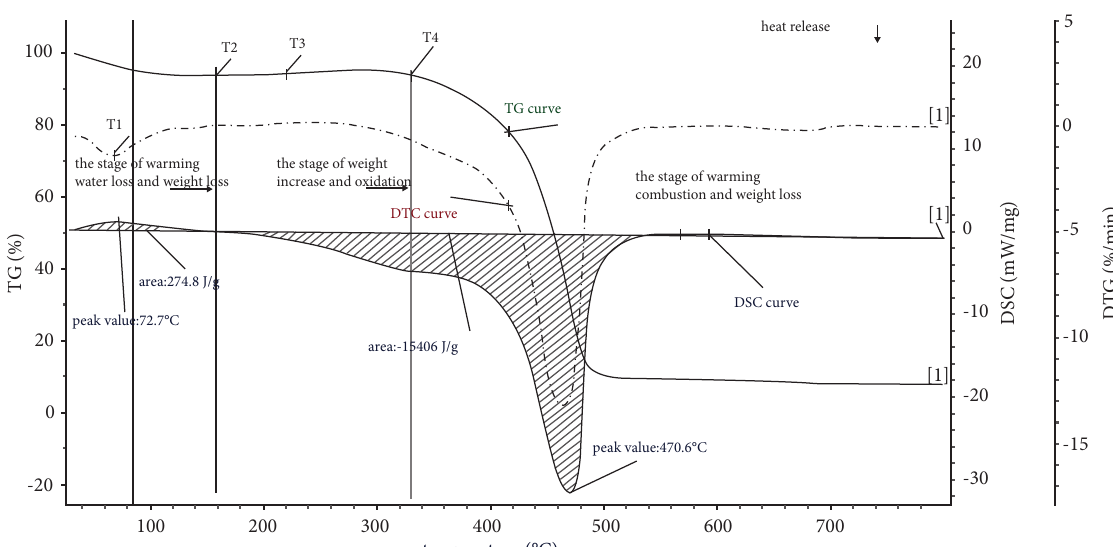
Figure 6: TG/DTG/DSC results for the Bulianta 12# raw coal sample at a heating rate of 10 ° C/min in